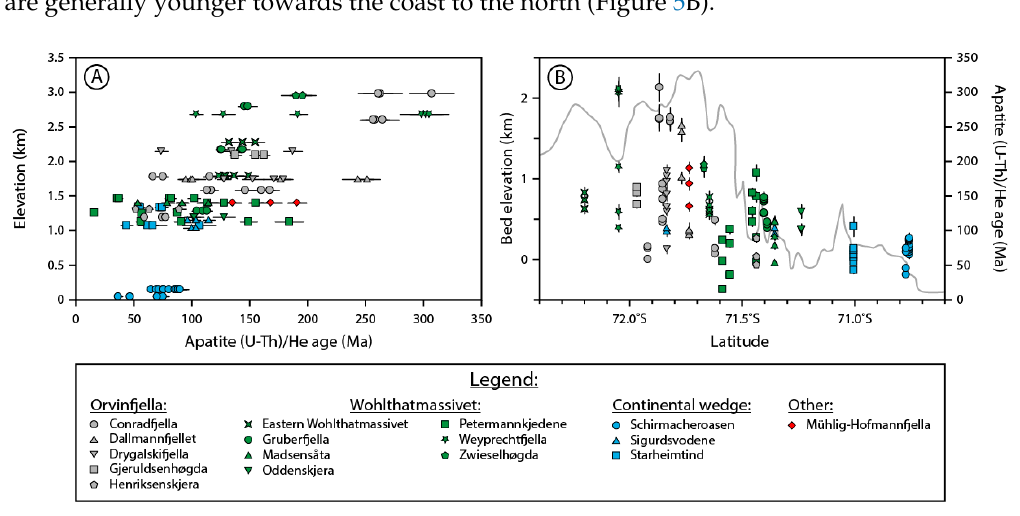
Figure 5. Apatite (U-Th)/He data from 33 samples. Reported errors are 1 σ . ( A ) Single-grain apatite (U-Th)/He ages correlate moderately well with elevation. ( B ) The apatite (U-Th)/He analyses yield progressively older ages towards the inland, similar to the apatite fission track analyses. A topographic cross section as in Figure 4 is included in gray.